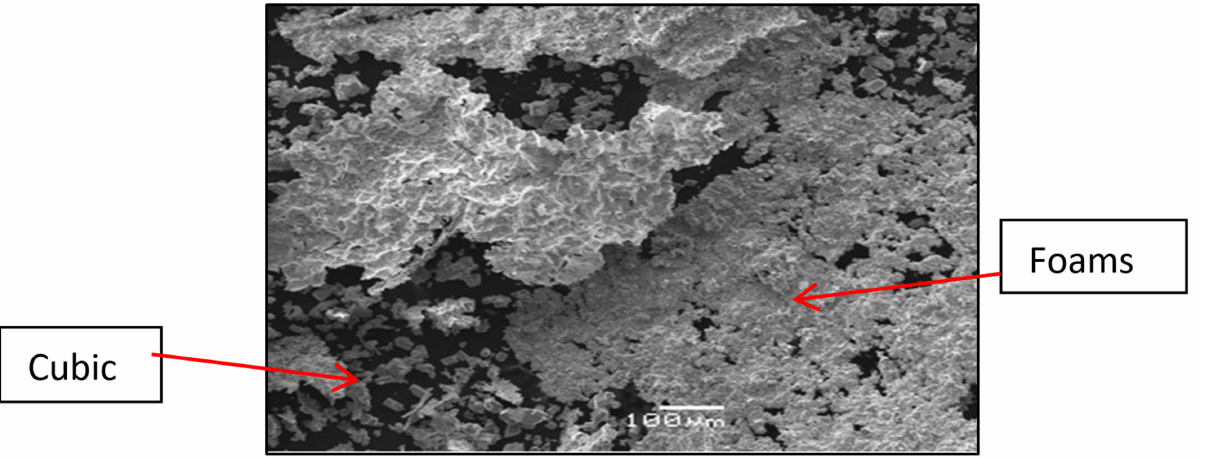
Figure 12. SEM image for the pyrolytic precursor from PS-co-4-PVP · (ZnCl 2 ) n in ratio 1:5. Adapted from reference